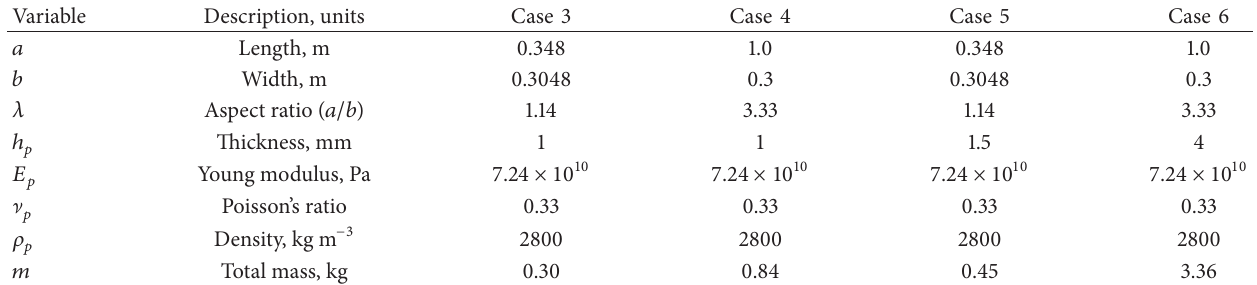
Table 2: Physical properties of isotropic panels.